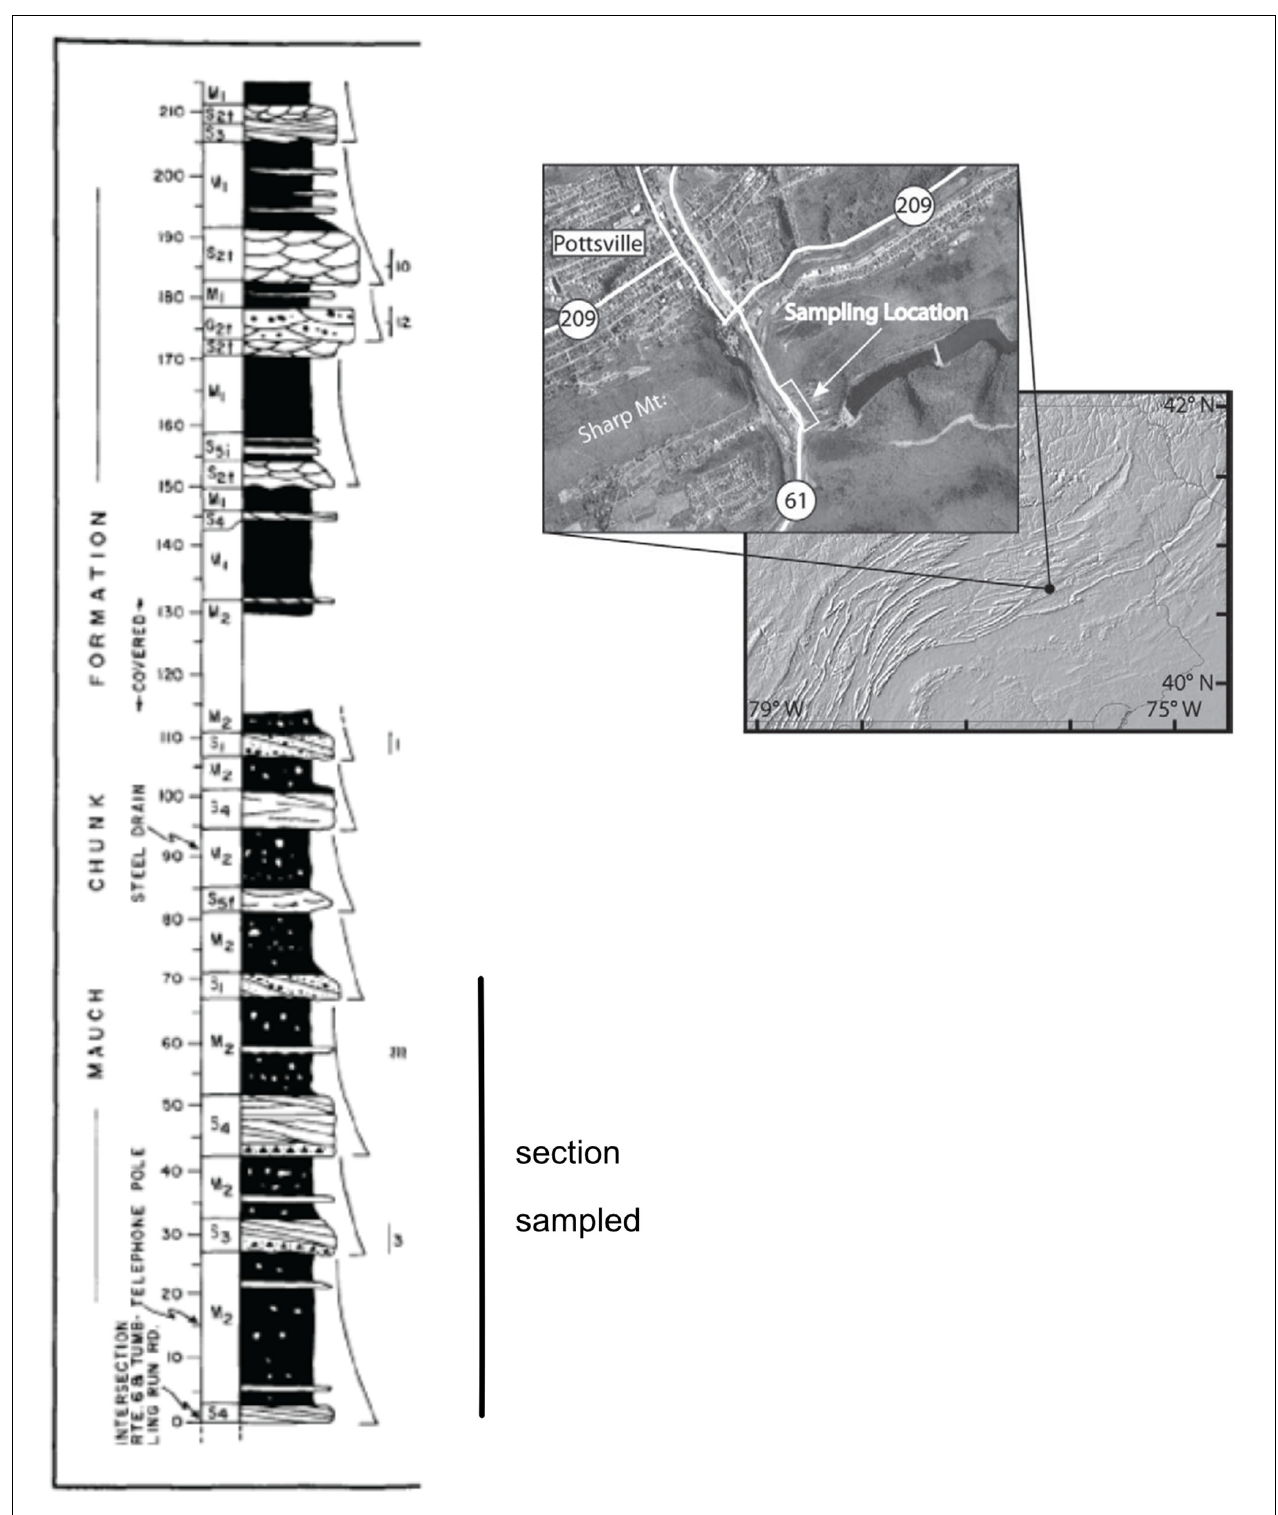
FIGURE 1 | (Left) Stratigraphic column of the Pottsville, PA, Mauch Chunk Formation section from Levine and Slingerland (1987). (Right) Location of the Pottsville section of the Mauch Chunk Formation along Route 61 in northeastern Pennsylvania (from Bilardello and Kodama, 2010).